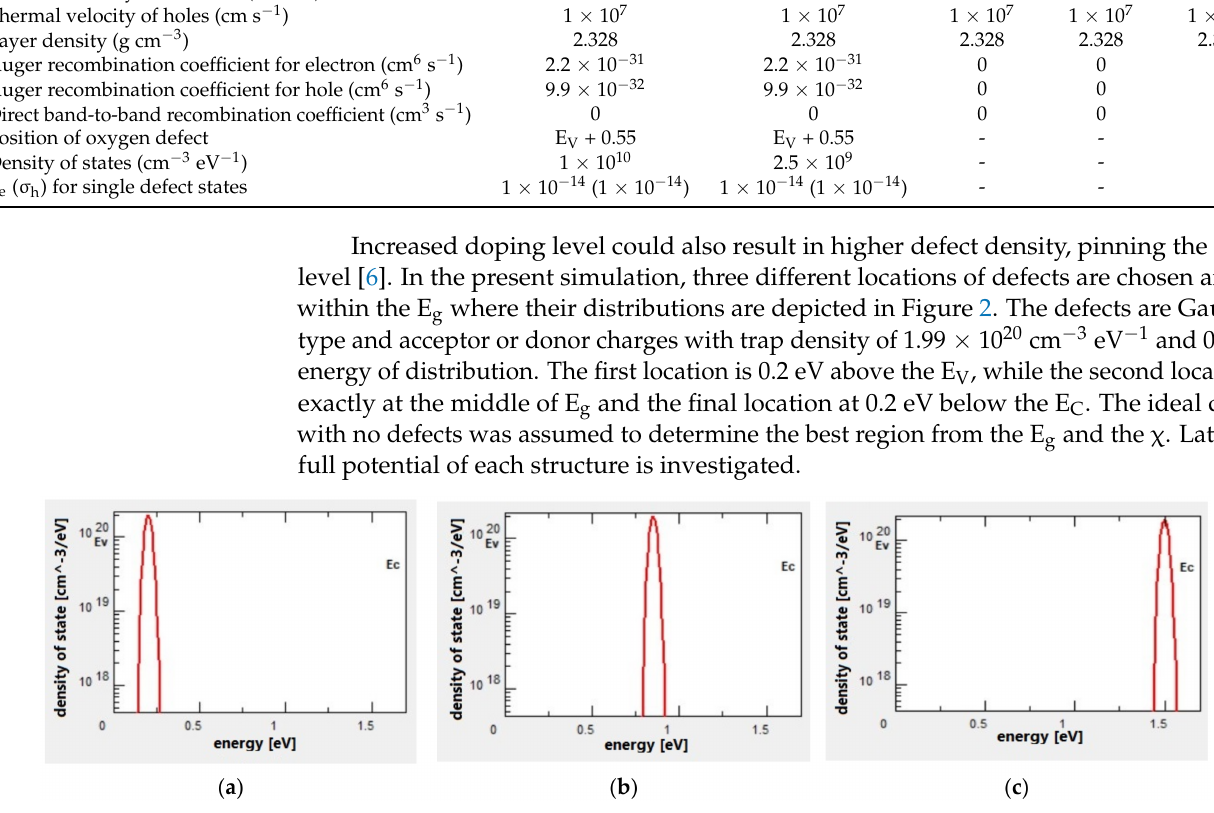
Figure 2. ( a – c ) Defect state distributions in a-Si